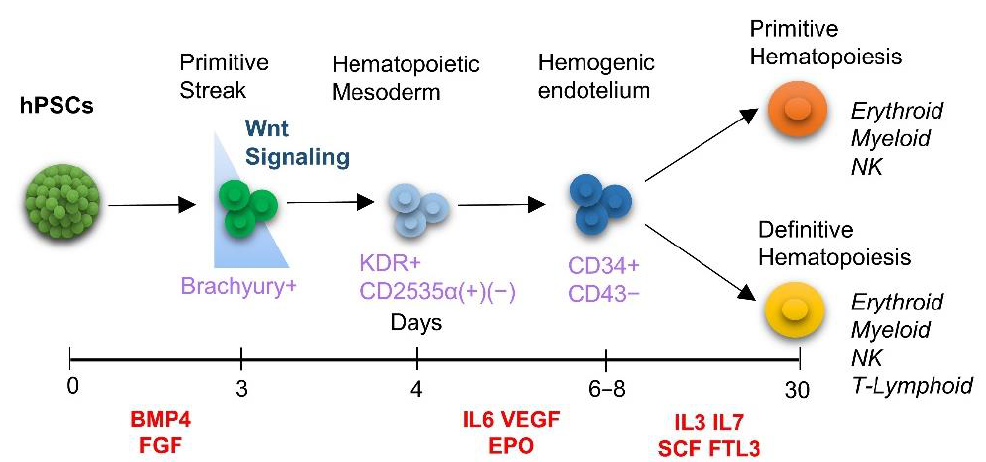
Figure 1. Schematic representation of current knowledge of in vitro differentiation of human pluripotent stem cells to hematopoietic lineage. Hematopoietic differentiation of hPSCs is depicted based on the protocols in the literature. Hematopoietic differentiation occurs in a consecutive stage-specific manner, starting with the BMP4-induced mesodermal commitment (days 0–4) followed by conventionally employed exogenous activation of Wnt/β -catenin signaling at this initial stage. The Lateral plate (Day 3-4) mesoderm generates endothelial progenitors (4-6), hemogenic endothelium with the potential to hematopoietic lineages (Day 6-8). At this latter stage, the population splits into two developmental programs/waves: primitive hematopoiesis, characterized by the formation of monocytic cell types, and definitive hematopoiesis with lymphoid potential. Abbreviations: FGF: Fibroblast Grow Factor, IL3: Interleukin 3 IL6: Interleukin 6, IL7: Interleukin 7, VEGF: Vascular En- dothelial Grow Factor, EPO: Erythropoietin, SCF: Stem Cell Factor, FLT3: receptor-type tyrosine- protein kinase. Table 1. Selected publications on the independent use of 3D/Embryoid Body and 2D/monolayer systems in hematopoietic differentiation from hPSCs. The table displays the differences in the generation of hematopoietic lineages under these two conditions. Additionally , results show the importance of Wnt/β -catenin signaling activation during in vitro differentiation of hPSCs of the definitive hematopoietic fate.